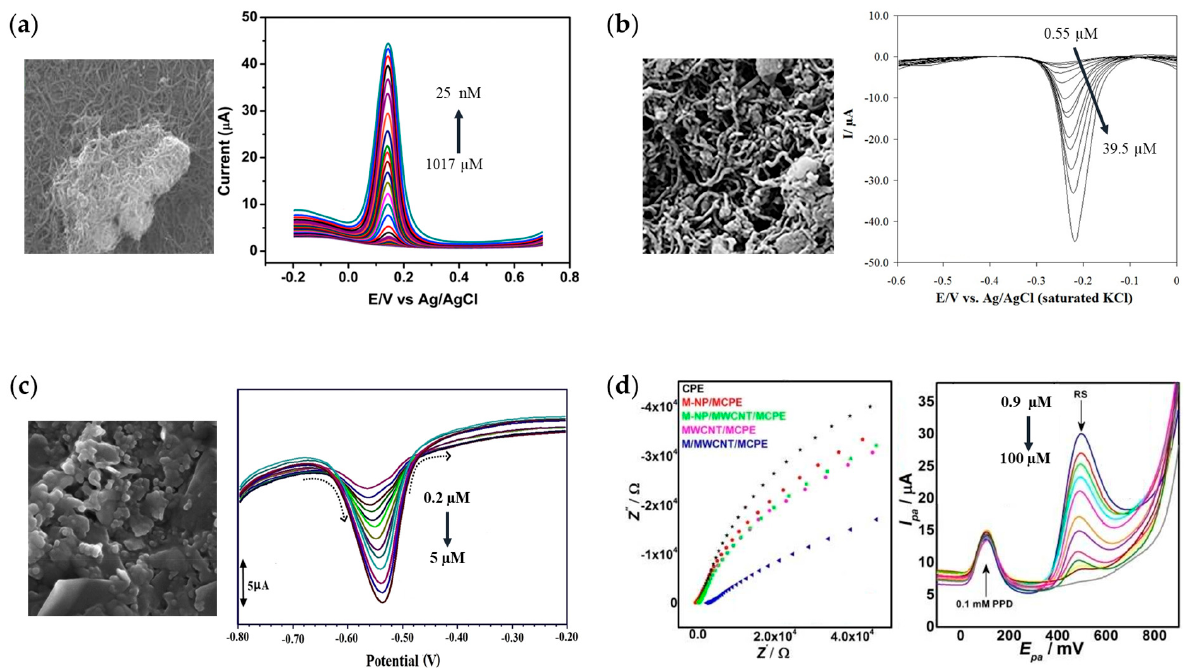
Figure 12. ( a ) Determination of the neurotransmitter dopamine by DPV on binary metal sulfides hybrid/functionalized MWCNTs [116]. ( b ) Sensitivity toward Cr in wastewater via polyaniline/sulfate zirconium dioxide/MWCNTs [119]. ( c ) Composite of pencil graphite and carbon nanotubes and its sensitivity to riboflavin [120]. ( d ) Rapid quantification of resorcinol in hair dye using Maghemite/MWCNTs composite [121].